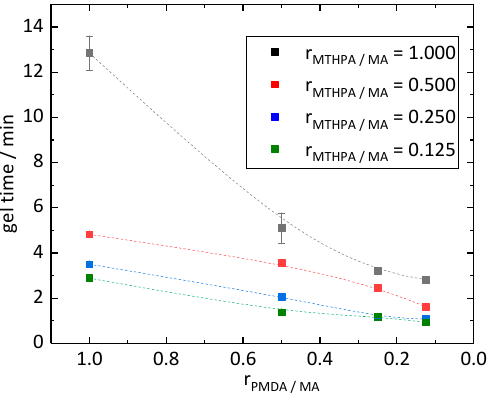
Figure 2. Gel time of epoxide resins in reference to the molar ratios r PMDA/MA and r MTHPA/MA